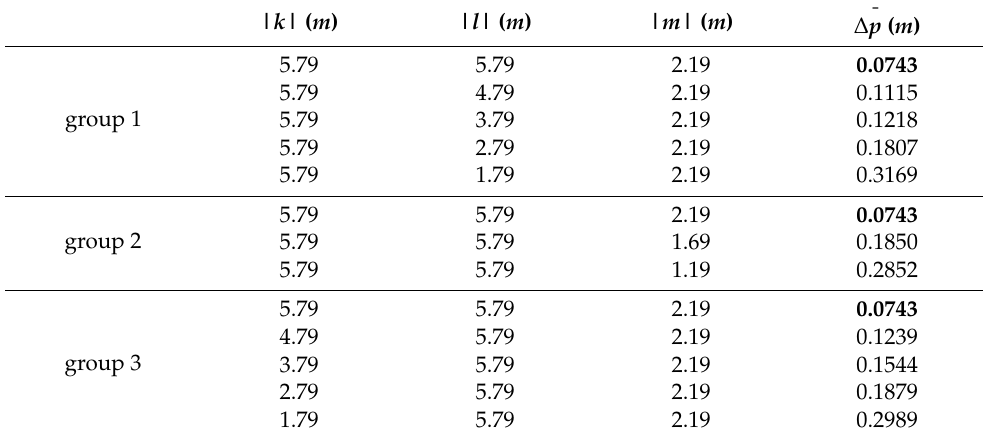
Table 10. The 3D RMSPE ∆ p with varying anchor distances | k | , | l | , and | m | for the LOS